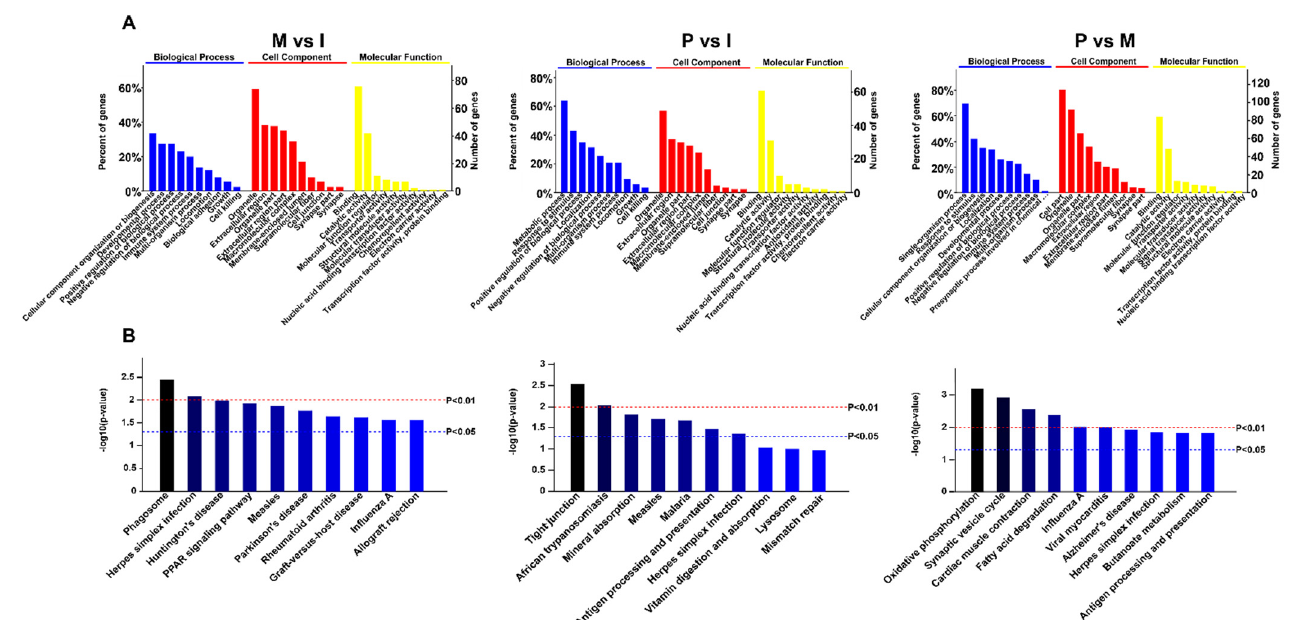
Figure 3. Identification and function analysis of DEPs. ( A ) GO analysis of the DEPs; ( B ) KEGG analysis of the DEPs.